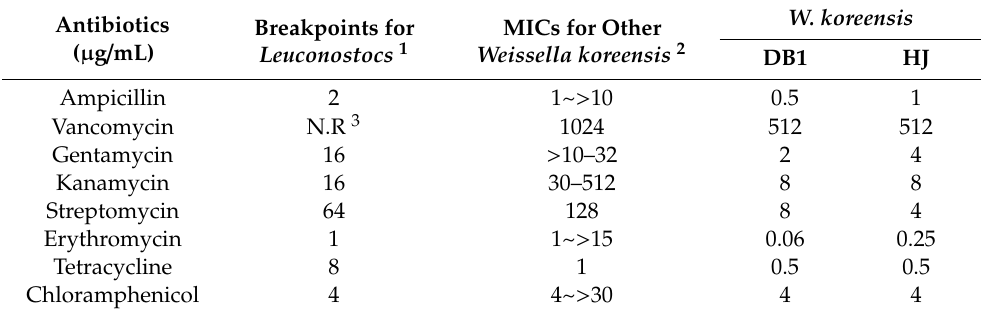
Table 3. Minimum inhibitory concentrations (MICs) of antibiotics for